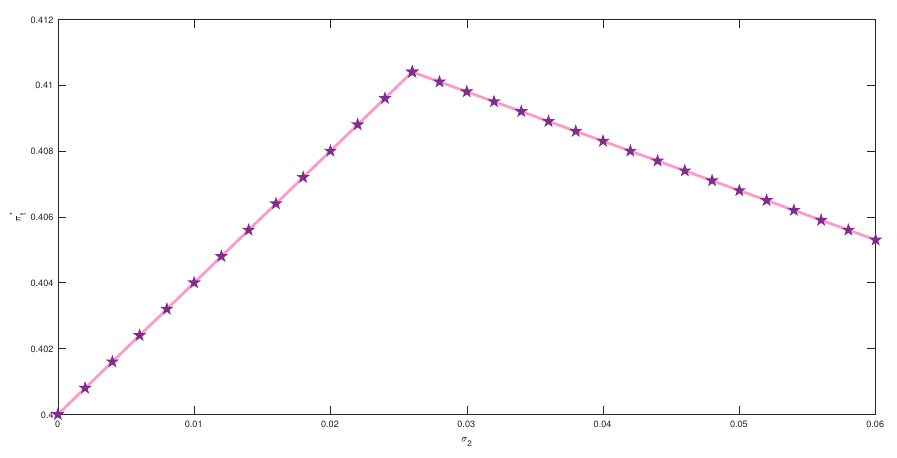
Figure 3. Effect of parameter σ 2 on π ∗